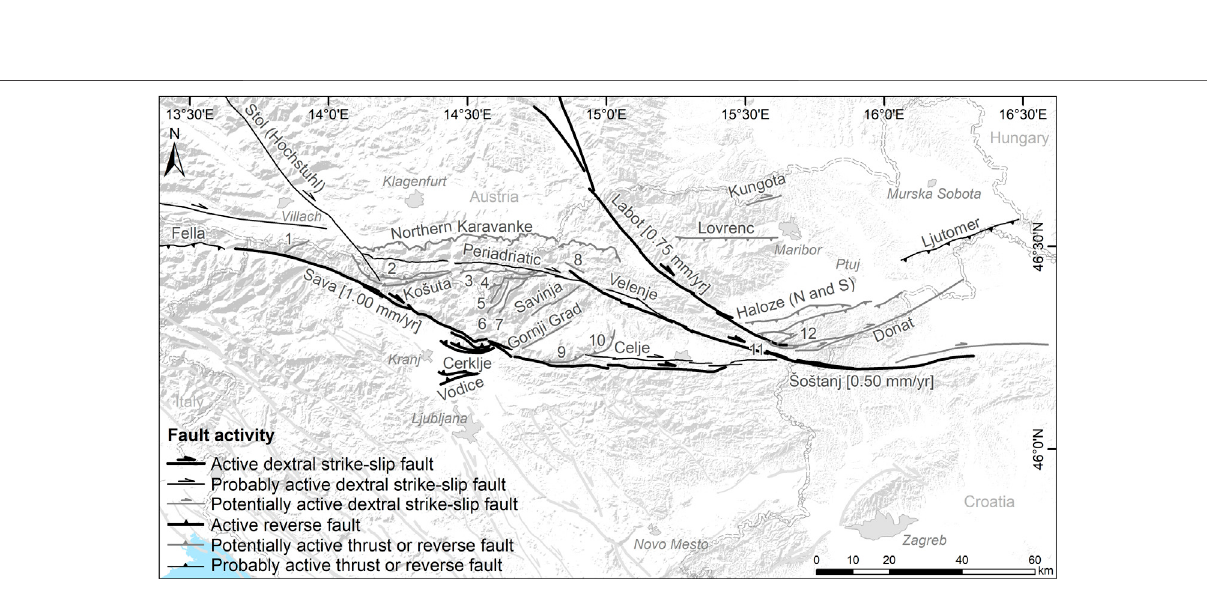
faults ( Figure 10 ): one active (Toplice fault), three probably (Sti ˇ cna fault, Zagorje fault, Hrastnik fault) and four potentially active faults (Litija fault, Trebnje fault, Ponovi ˇ ce fault, Dobovec fault). The two longest faults in this fault set are the Toplice fault (37 km) and the Hrastnik fault (49 km). Inferred slip rates are